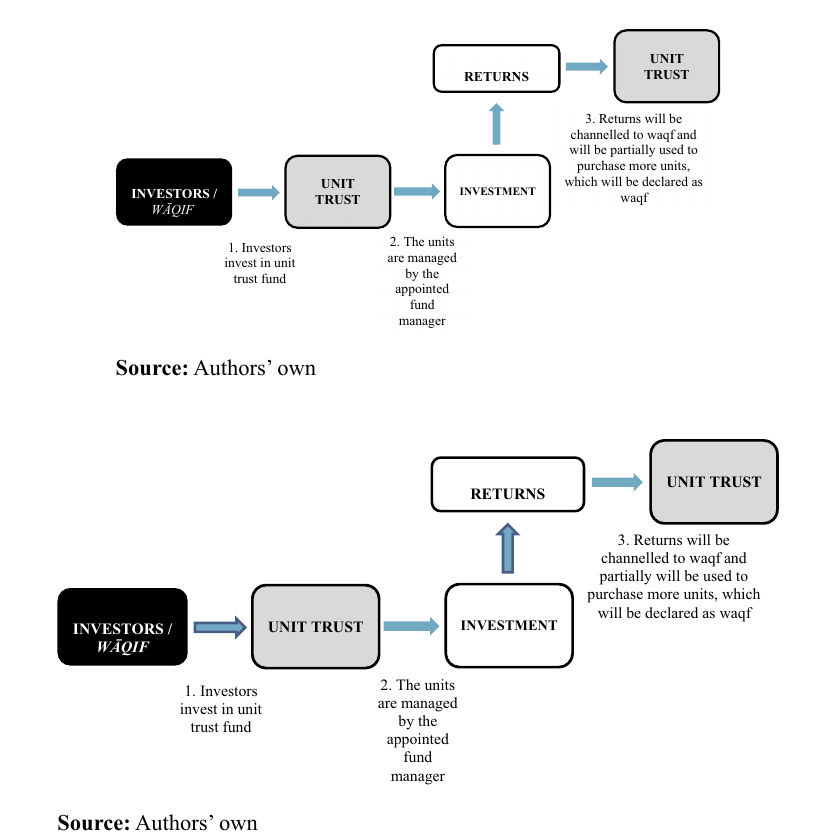
Figure 5. Fourth proposed